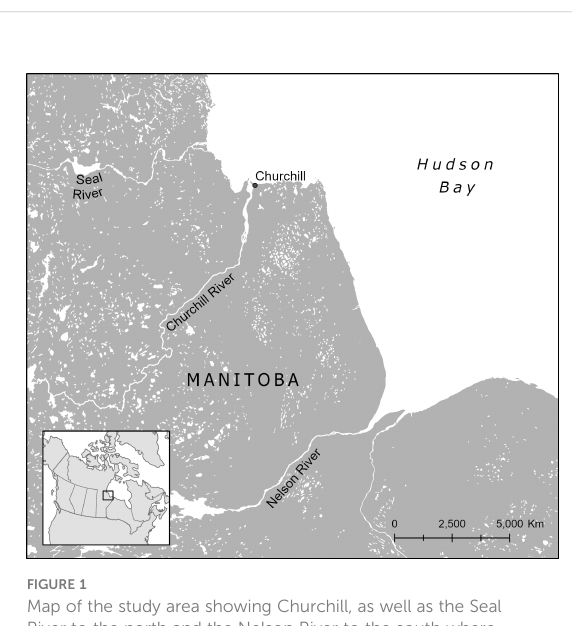
FIGURE 1 Map of the study area showing Churchill, as well as the Seal River to the north and the Nelson River to the south where larger aggregations of belugas are located in